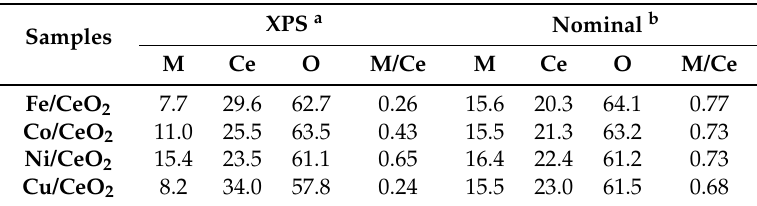
Table 4. Bulk and surface—X-ray Photoelectron Spectroscopy (XPS)—atomic concentrations (at%) for 20 wt.% M/CeO 2 catalysts.